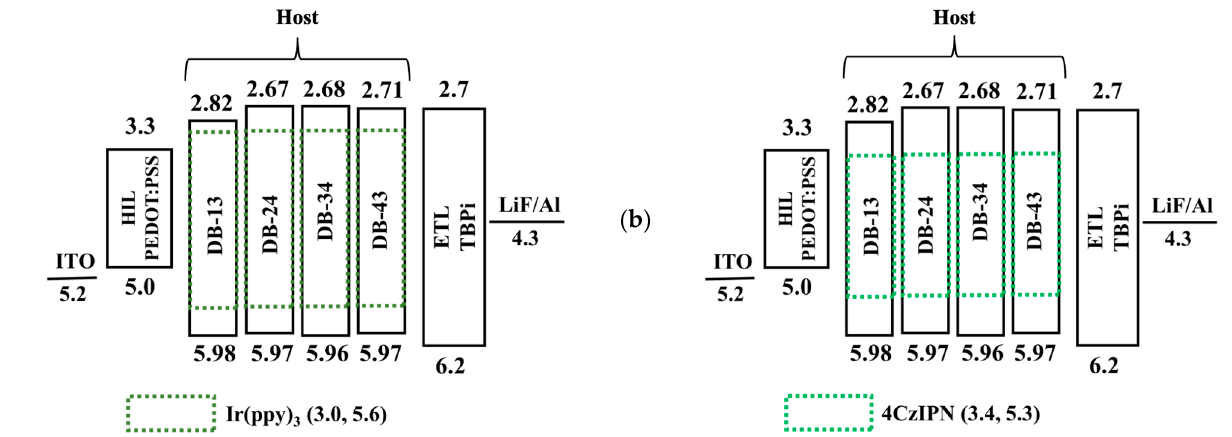
Figure 16. Energy-level diagram in eV of the solution-processed green OLED devices containing hosts DB13, DB24, DB34, and DB43, doped with commercial ( a ) phosphorescent green emitter Ir(ppy) 3 and ( b ) commercial TADF green emitter 4CzIPN.